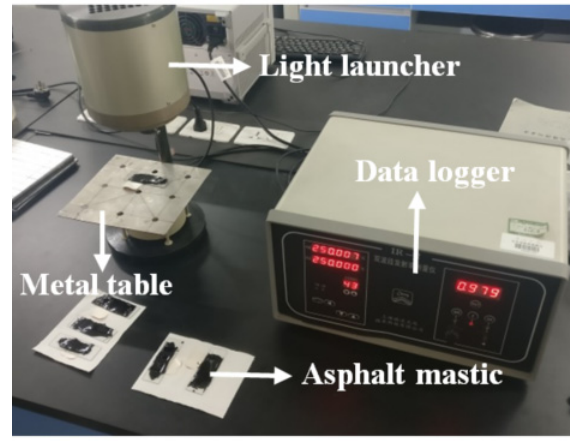
Figure 3. Emissivity measuring instrument.